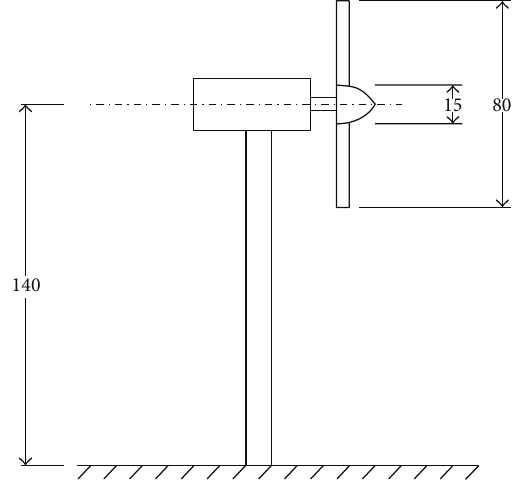
Figure 3: Main small-scale wind turbine